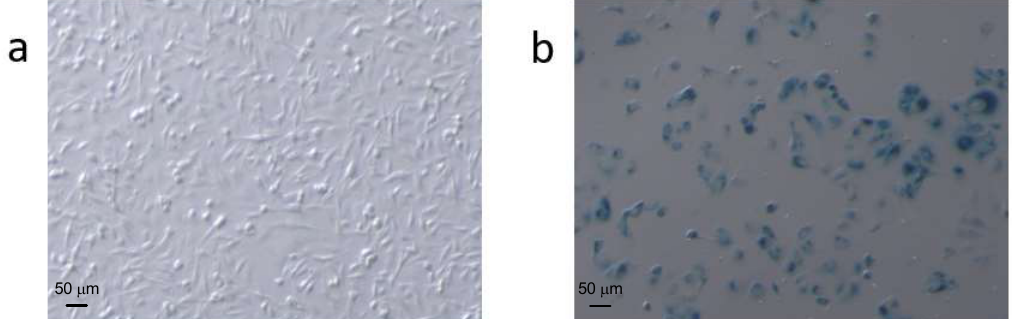
Figure 1. Comparison of ( a ) normal and ( b ) Adriamycin (ADR)-treated MCF7 cells stained for SA- β -gal activity. ADR-treated cells were larger and had a flatter morphology than untreated cells. Cell counting (250 cells per condition) showed that the number of SA- β -gal-positive (blue) cells versus the number of total cells was approximately 4% in the untreated cells and ~60% in the treated cells.